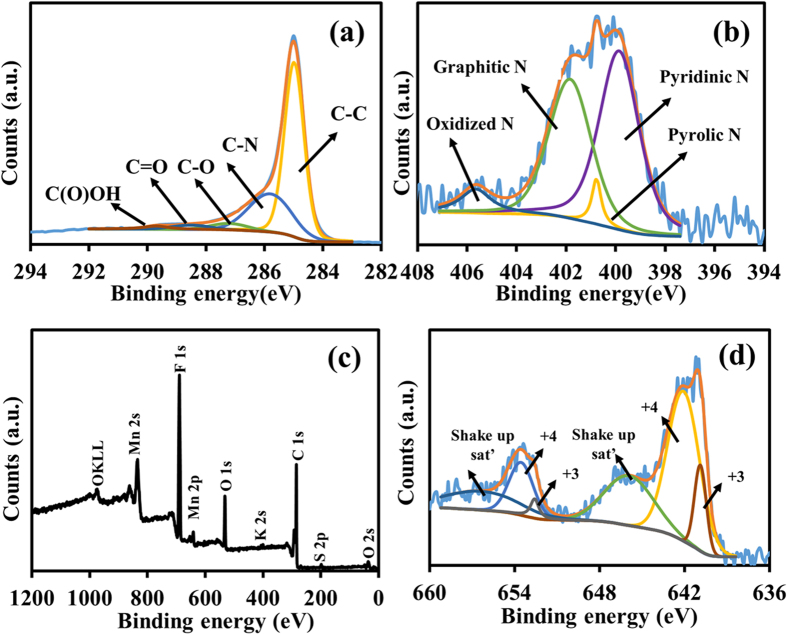
(a) C1s and (b) N1s XPS spectra of N-rGOae on c-CFP, (c) XPS survey, and (d) Mn2p XPS of MnO2.